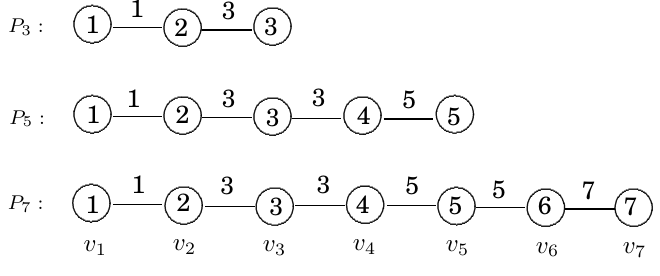
Figure 2: Rainbow mean colorings of P